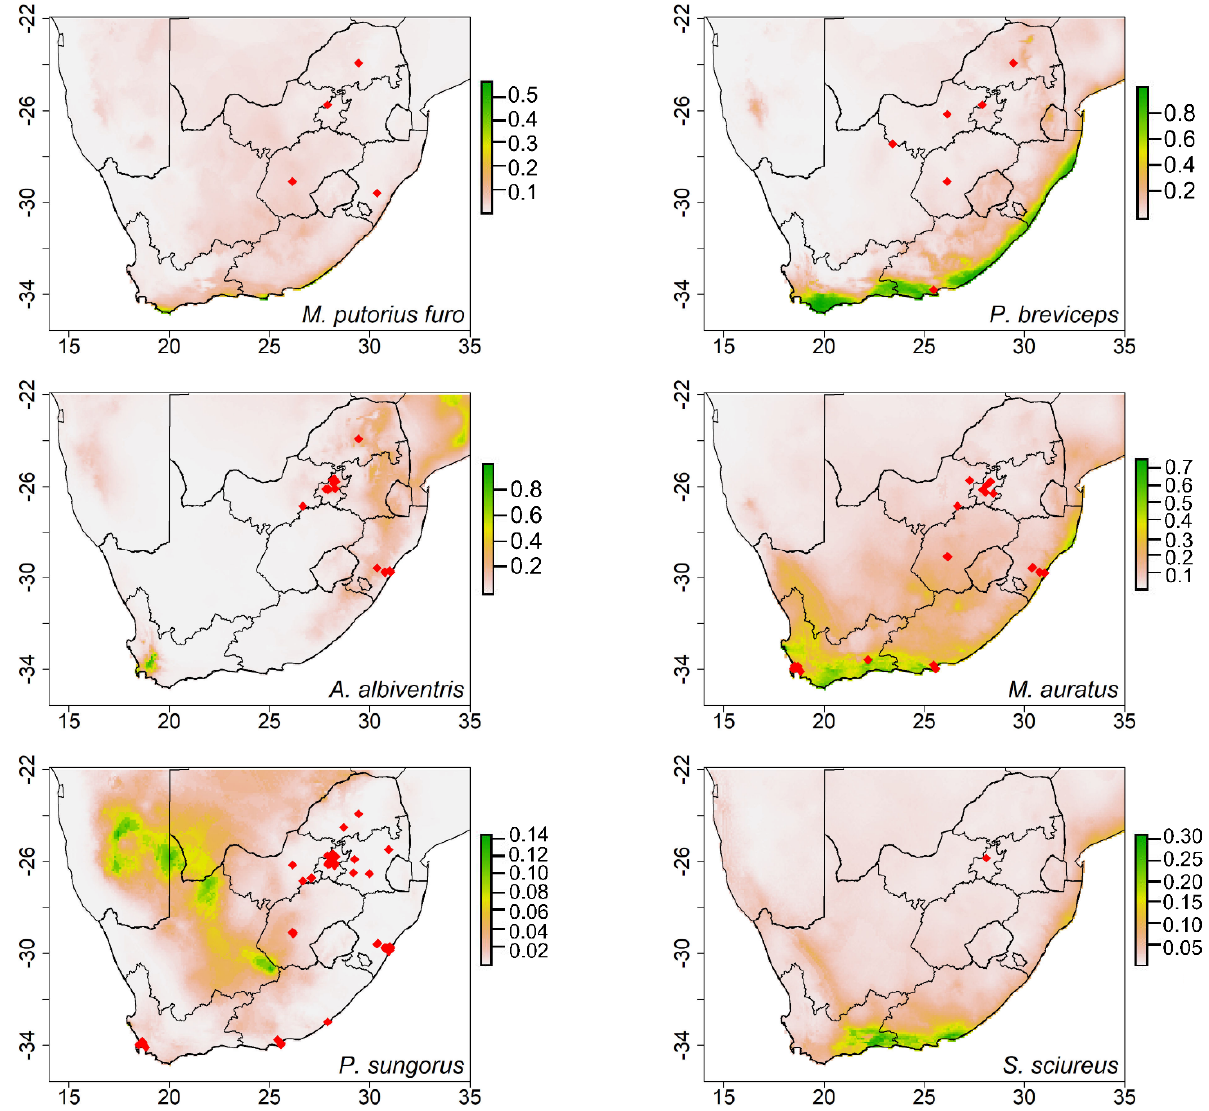
Figure 4. The potential distribution maps showing the areas that are potentially climatically suitable for domesticated ferrets ( Mustela putorius furo ), sugar gliders ( Petaurus breviceps ), African pygmy hedgehogs ( Atelerix albiventris ), golden hamsters ( Mesocricetus auratus ), winter dwarf hamsters ( Phodopus sungorus ) and common squirrel monkeys ( Saimiri sciureus ) in South Africa. (Note: The color ramp threshold on the right measured the climatic suitability: green indicates the most climatic suitable areas, decreasing to yellow and orange, with light gold and white being unsuitable). Red dots indicate selling points.